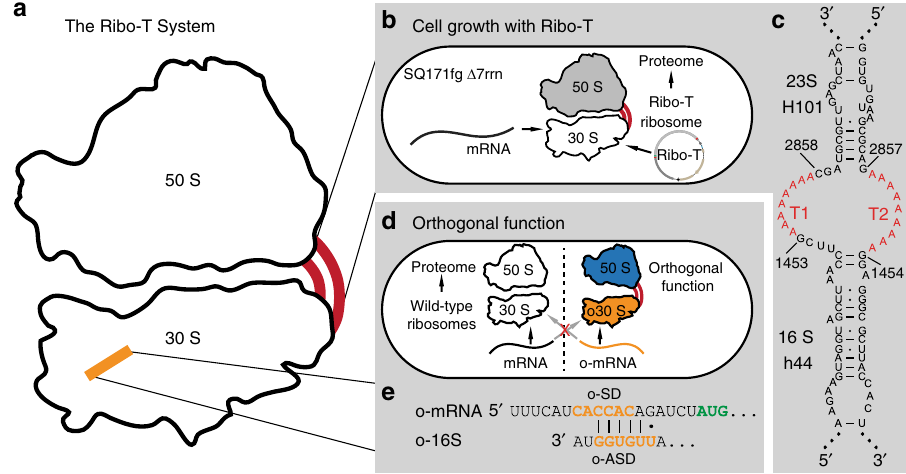
Fig. 1 Ribo-T system improvement strategies. a Schematic of Ribo-T showing tether (red) and orthogonal ribosome binding site (yellow). b The tether is optimized in cells growing exclusively from the Ribo-T plasmid. c Previously published Ribo-T tether sequence. d Orthogonal function evolved for Ribo-T. e Previously published orthogonal mRNA (o-mRNA) Shine-Dalgarno (SD) sequence and orthogonal 16S rRNA anti-SD (o-ASD) sequence